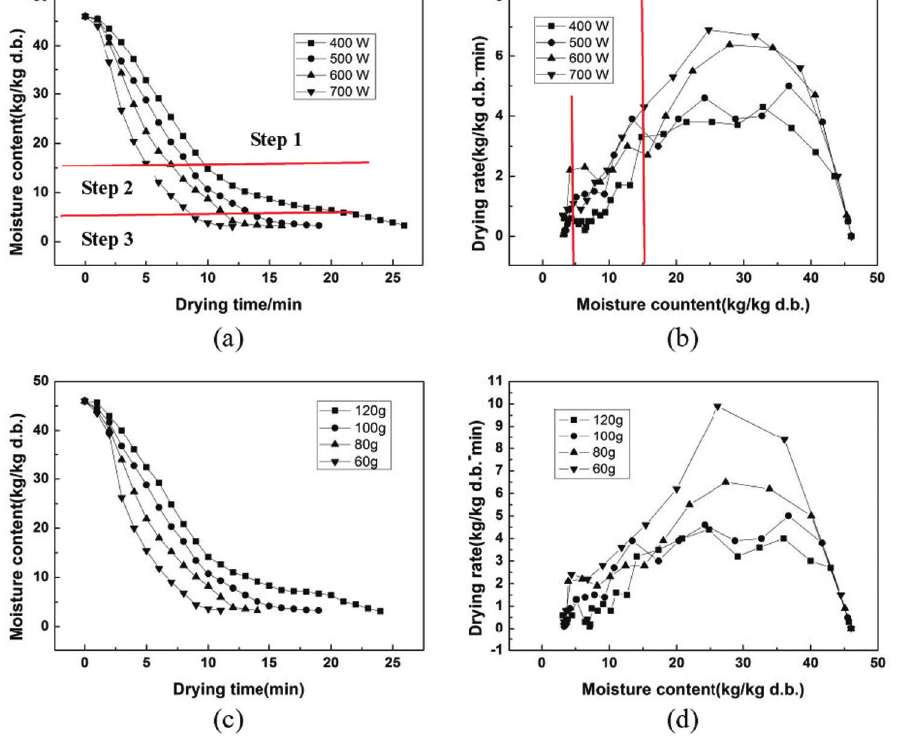
Figure 6: Microwave drying curves of NCR. (a) Drying curves of 100 g sample at different microwave powers, (b) drying rate curves of 100 g sample at different microwave powers, (c) drying curves with a different sample mass at 500 W and (d) drying rate curves with a different sample mass at 500